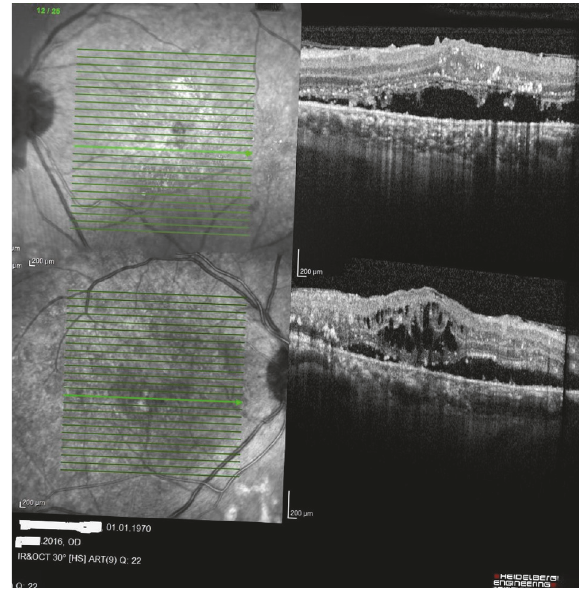
Figure 2: Central serous chorioretinopathy was seen on left eye’s OCT image (superior image). Central serous chorioretinopathy was seen on right eye’s OCT image (inferior image).